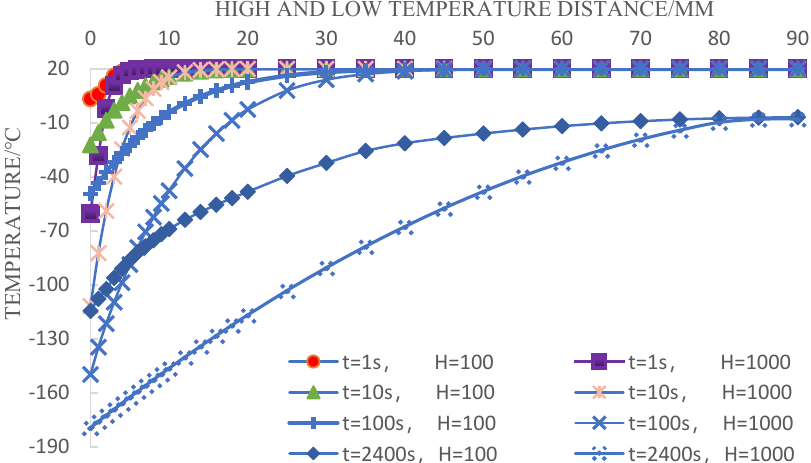
Figure 16. Evolution of the heat transfer coefficient of the temperature distributions on the boundary at different times.